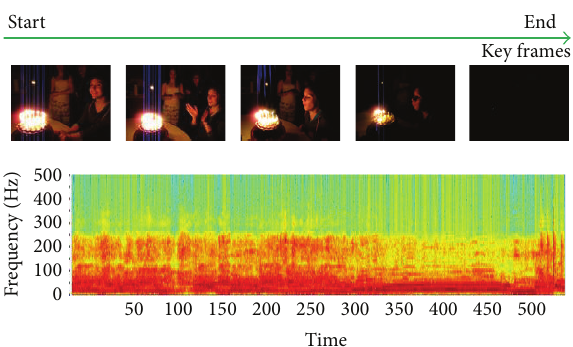
Figure 6: An example of audio-visual correlations in the event “Birthday” of CCV dataset.